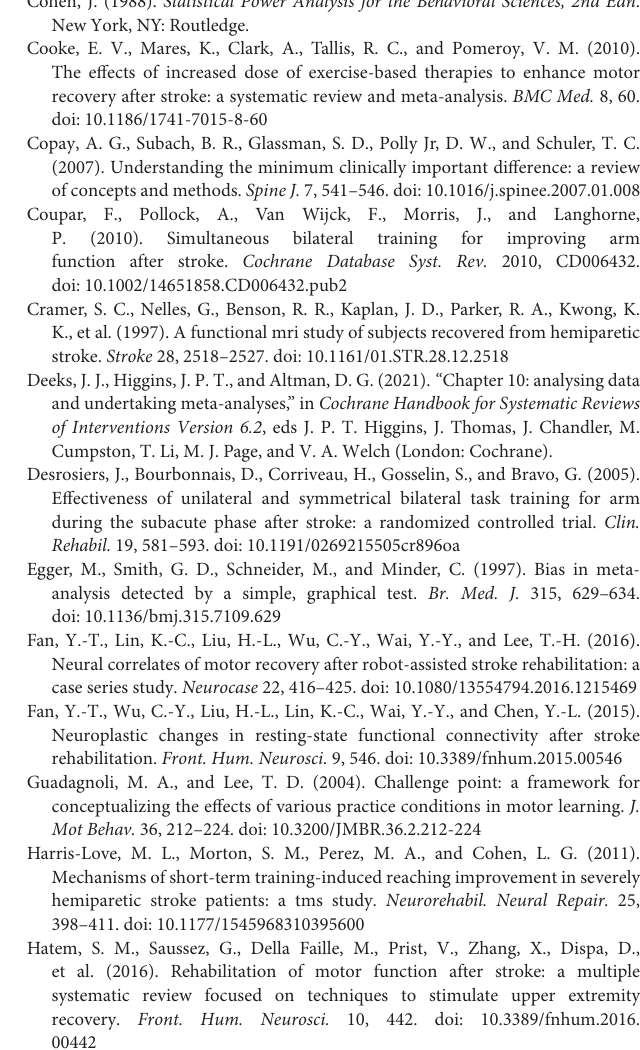
Supplementary Figure 1 | The effects of bilateral functional task training (BFTT) on the upper extremity (A) motor impairments and (B) functional performance. BAT, bilateral arm training; CI, confidence interval; CT, conventional therapy; FE, fixed-effects; RE, random-effects; Std. Mean Diff., standardized mean difference. ∗ indicates statistically significant ( p < 0.05). Supplementary Figure 2 | Forest plots comparing the effects of (A) BAT vs. CT and (B) BAT vs. UAT on the MAL-amount of use. 1 = bilateral functional training Test (BFTT); 2 = bilateral robot-assisted training (BRAT); 3 = bilateral arm training with rhythmic auditory cueing (BATRAC); 4 = mirror therapy (MT); BAT, bilateral arm training; CI, confidence interval; CT, conventional therapy; FE, fixed-effects; RE, random-effects; Std. Mean Diff., standardized mean difference; UAT, unilateral arm training; ∗ indicates statistically significant ( p < 0.05). Supplementary Figure 3 | Forest plots comparing the effects of (A) BAT vs. CT and (B) BAT vs. UAT on the MAL-quality of movement. 1 = bilateral functional training Test (BFTT); 2 = bilateral robot-assisted training (BRAT); 3 = bilateral arm training with rhythmic auditory cueing (BATRAC); 4 = mirror therapy (MT); BAT, bilateral arm training; CI, confidence interval; CT, conventional therapy; FE, fixed-effects; RE, random-effects; Std. Mean Diff., standardized mean difference; UAT, unilateral arm training; ∗ indicates statistically significant ( p <